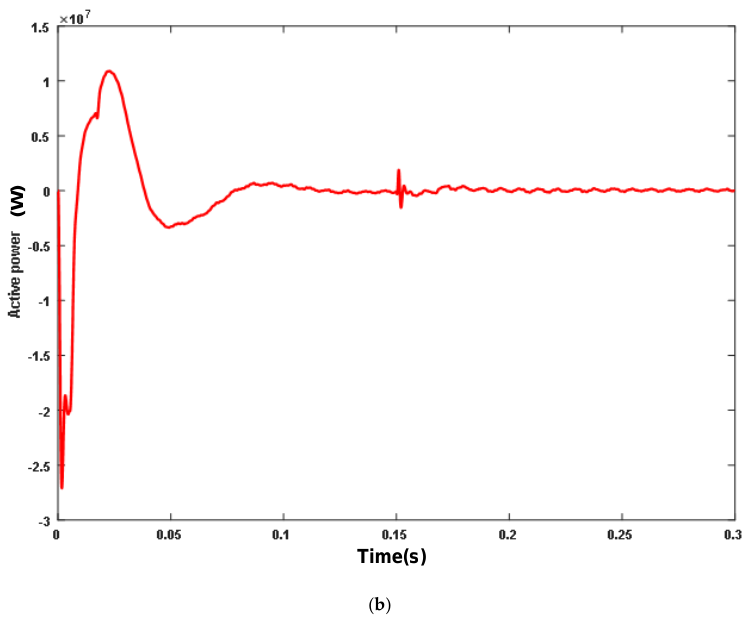
Figure 19. The reactive and active power with connection to the MMC STATCOM. ( a ) Reactive power; ( b ) Active power.